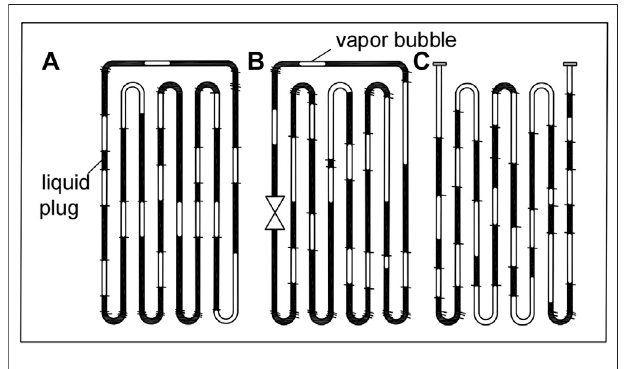
FIGURE 1 | Different forms of pulsating heat pipes: (A) Closed-loop PHP; (B) closed-loop PHP with a check valve; (C) open-loop